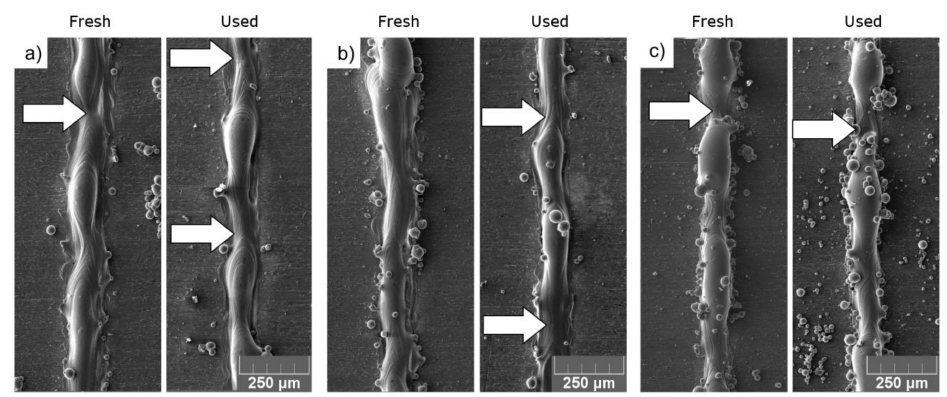
Figure 3. Representative SEM pictures of single tracks printed using FRESH and USED Ti6Al4V powder at a powder depth of ( a ) 25, ( b ) 60 and ( c ) 100 µ m. Arrows indicate the spots where the deposited material is